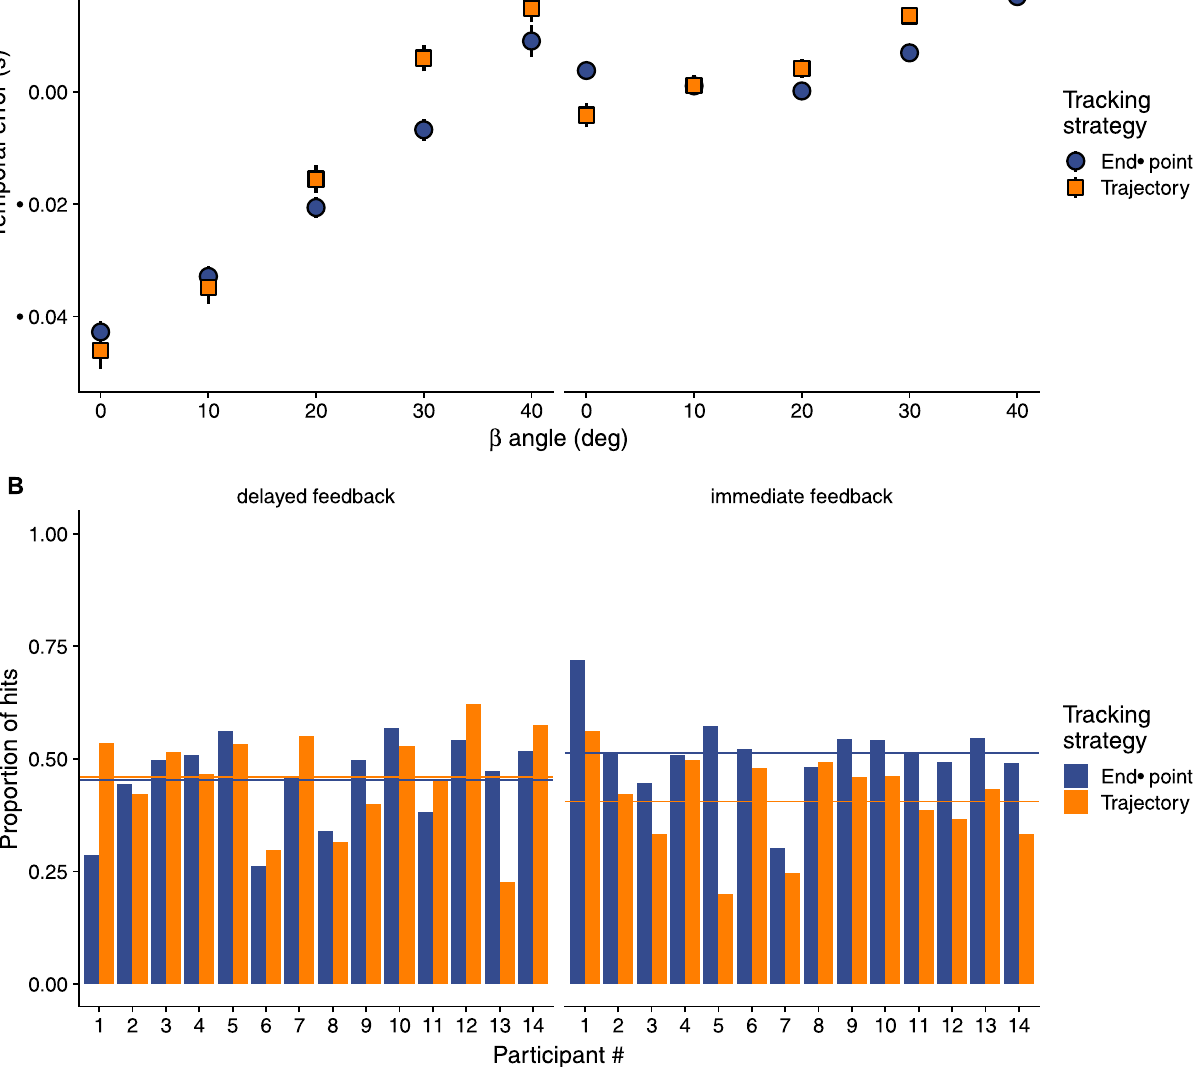
diate feedback condition similar significant effects were obtained except for the effect of target speed which was marginal ( F ( 2,357 ) = 2.85, p = 0.06). The angle of approach was significant ( F ( 1,358 ) = 38, p < 0.001) as well as the